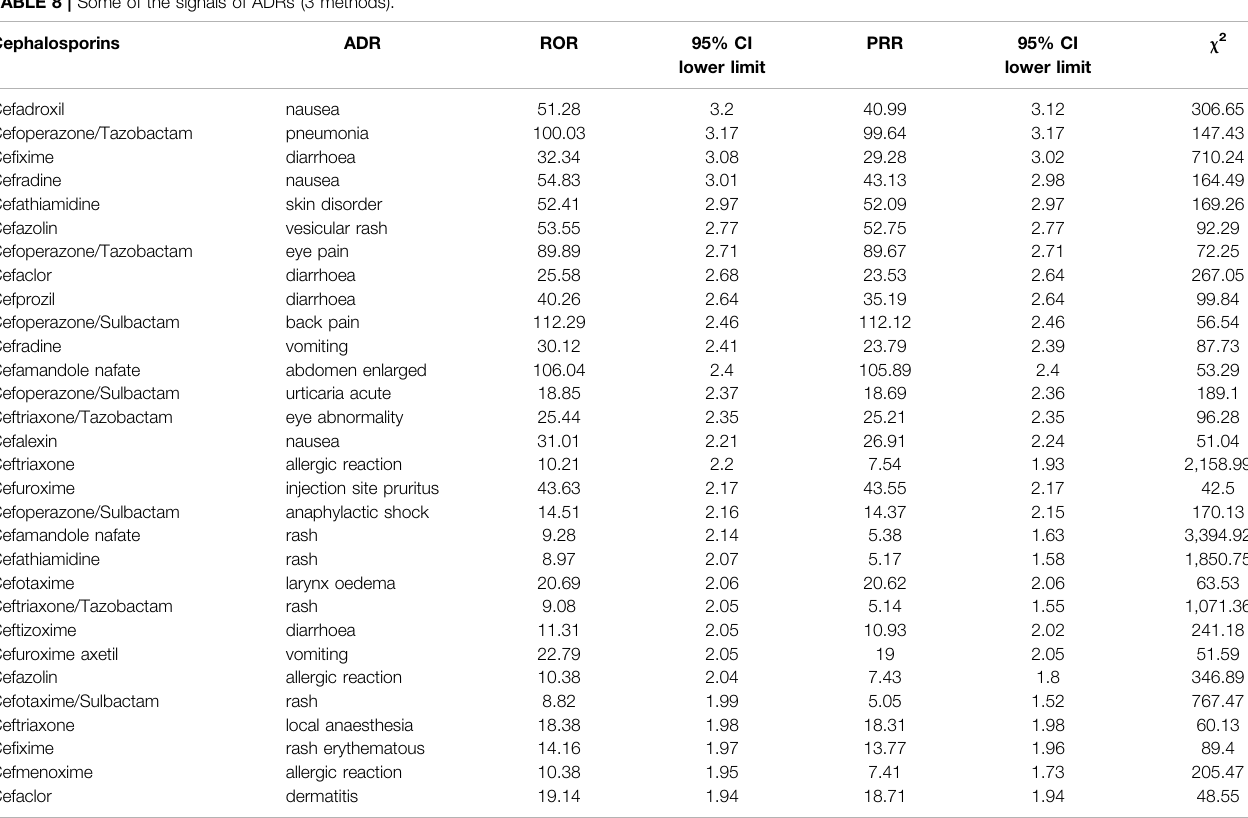
TABLE 8 | Some of the signals of ADRs (3